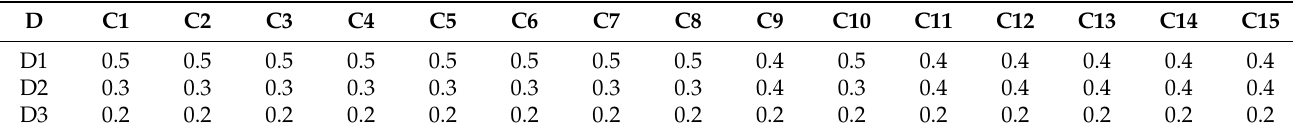
Table 16. Matrix of priorities